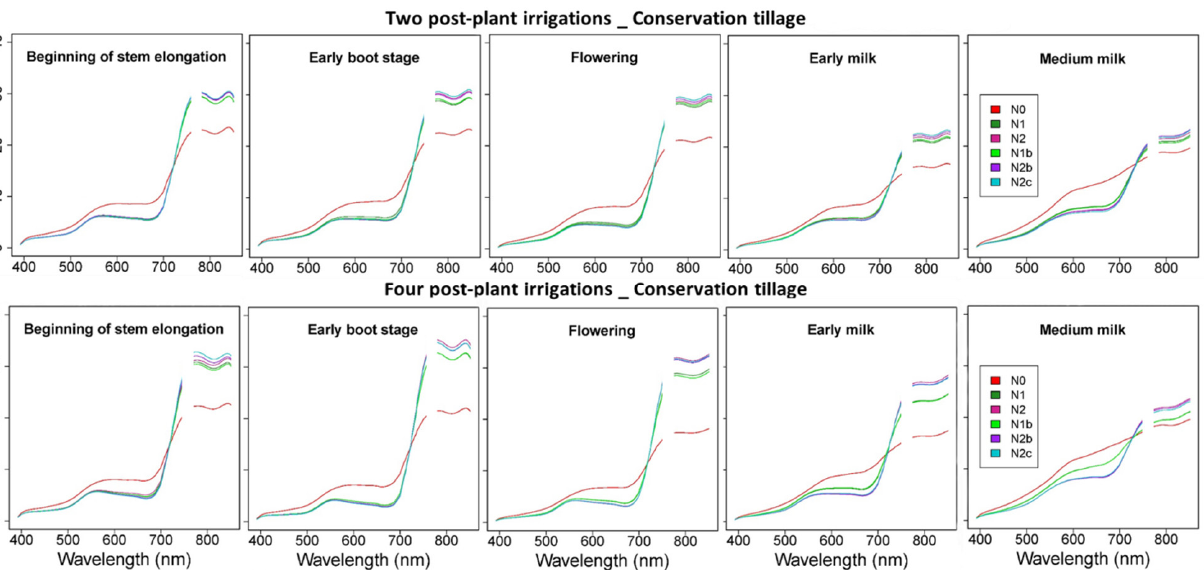
Figure 5. Spectral reflectance (%) from 400 nm to 850 nm, for the different N treatments (N0, N1, N1b, N2, N2b, and N2c) with conservation tillage, either with two post-plant irrigations (top row) or with four post-plant irrigations (bottom row), at five growth stages, in 2014. Treatment N0 has no fertilizer application; N1 received 125 kg N ha −1 split one-third at sowing and two-thirds in the first post-plant irrigation; N2 received 250 kg N ha − 1 split as one-third at sowing and two-thirds in the first post-plant irrigation; N1b received 125 kg N ha −1 split as two-thirds at sowing and one-third in the first post-plant irrigation; N2b received 250 kg N ha −1 split as two-thirds at sowing and one-third in the first post-plant irrigation, and N2c received 250 kg N ha −1 applied at sowing.